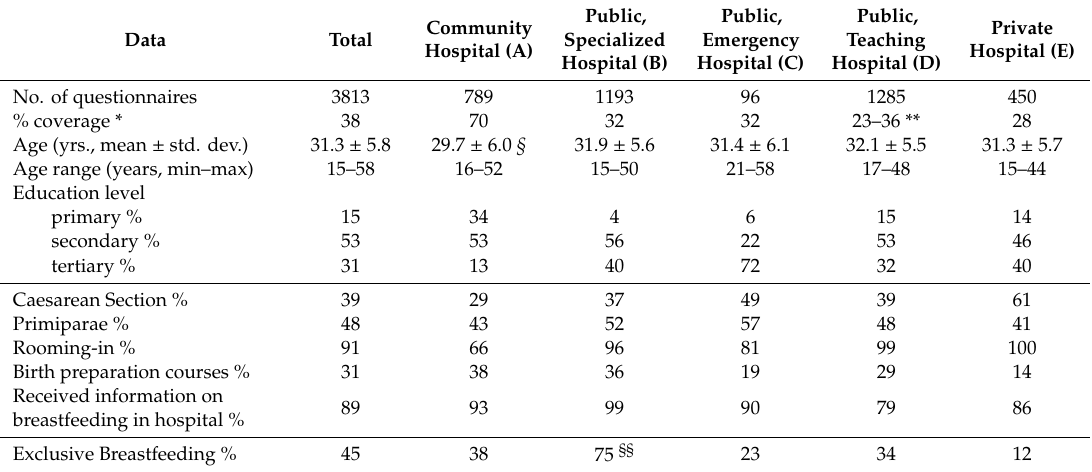
Table 1. Characteristics of Women from